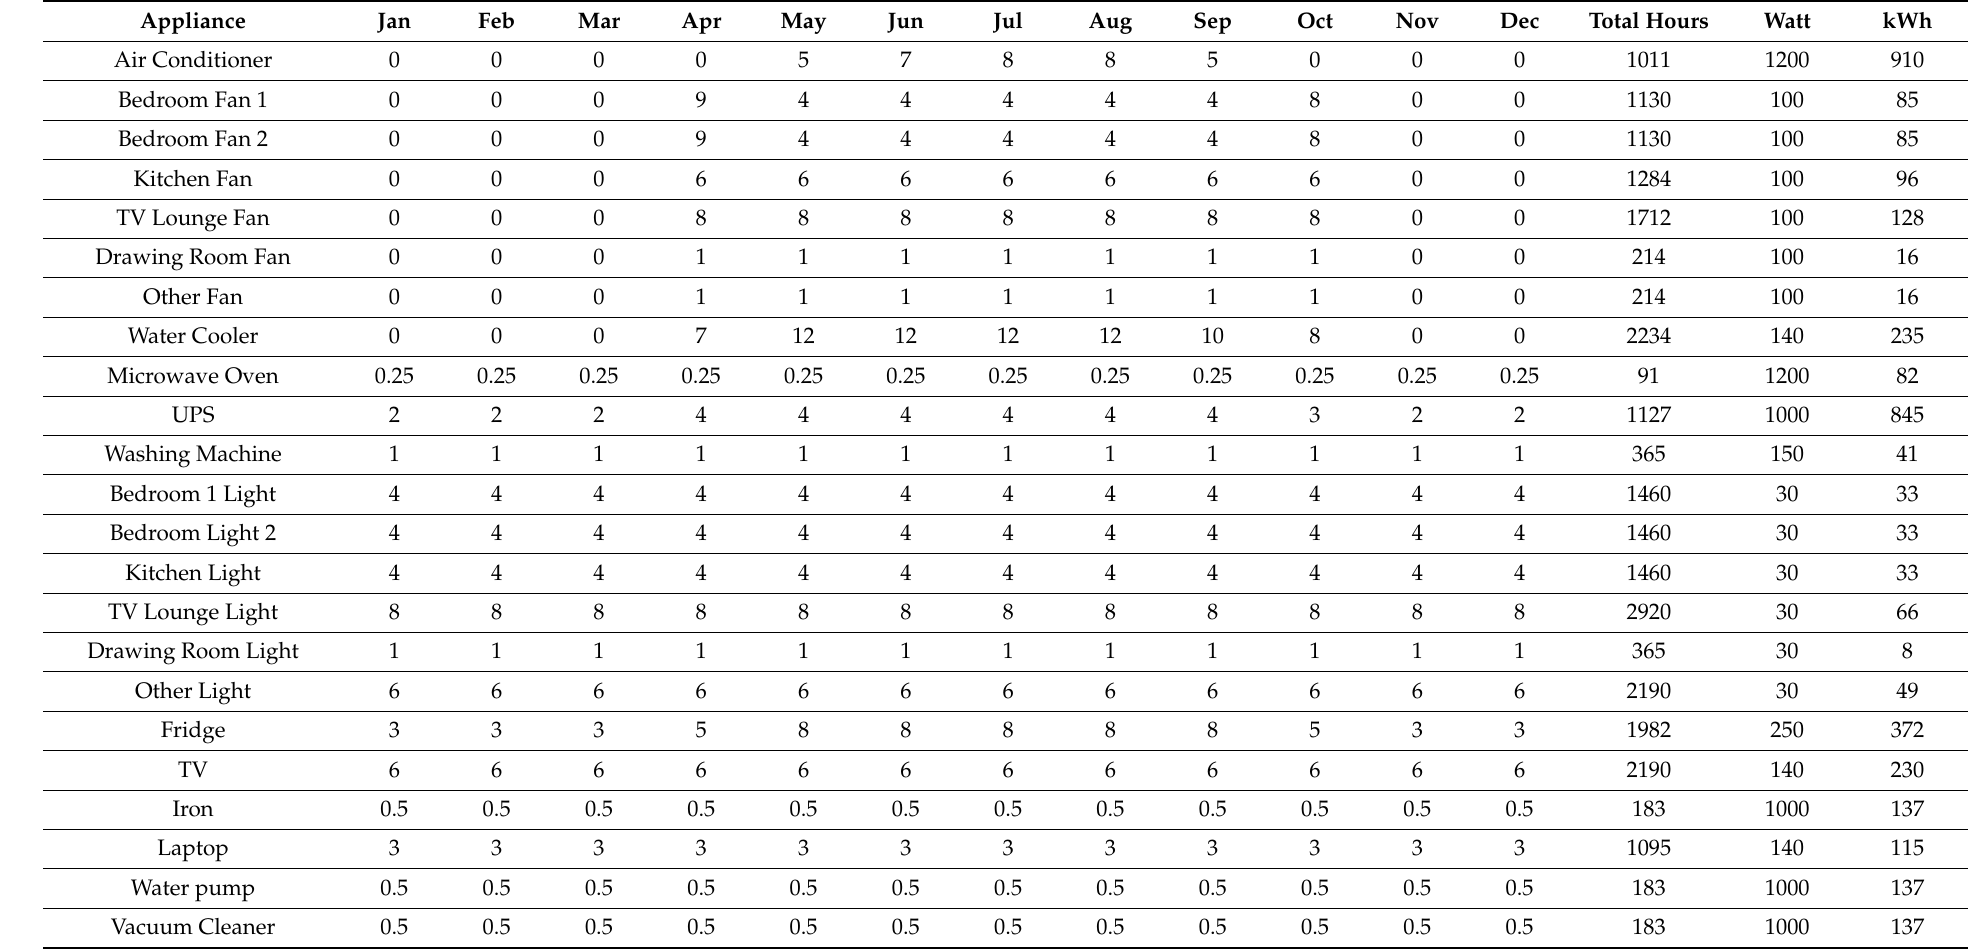
Table 6. Daily usage hours, watt ratings, and yearly electricity consumption of different